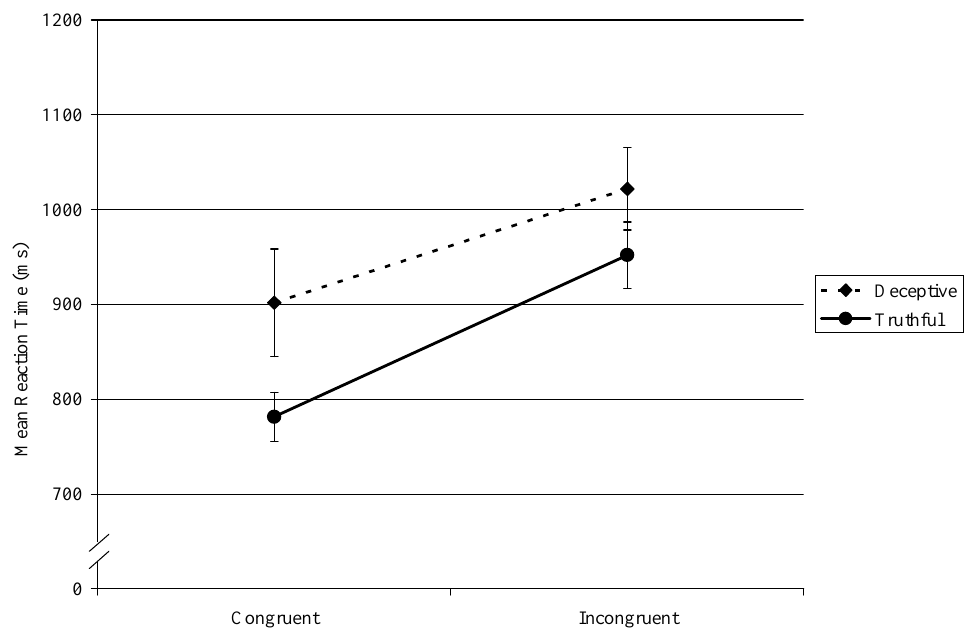
Fig. 5. Mean reaction time in a two-stimulus paradigm in which only response deception was predictable in Experiment 2.